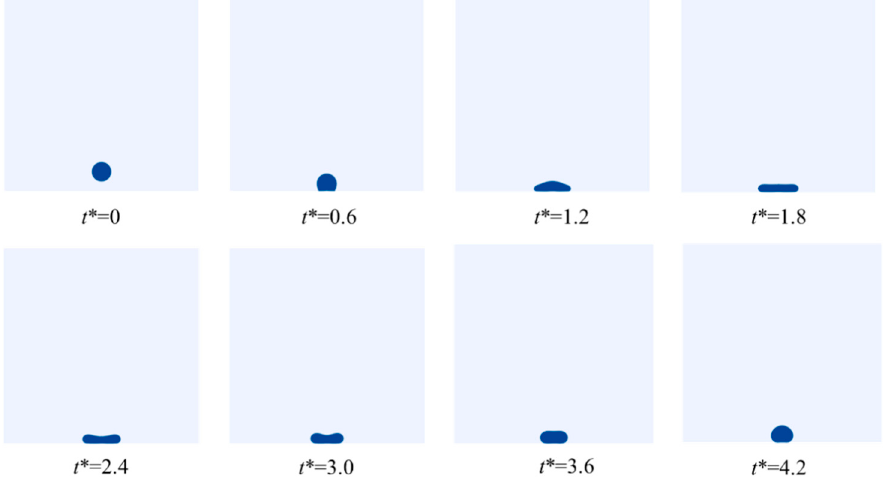
Figure 13. The spreading process of the oil droplet impinging the smooth wall.